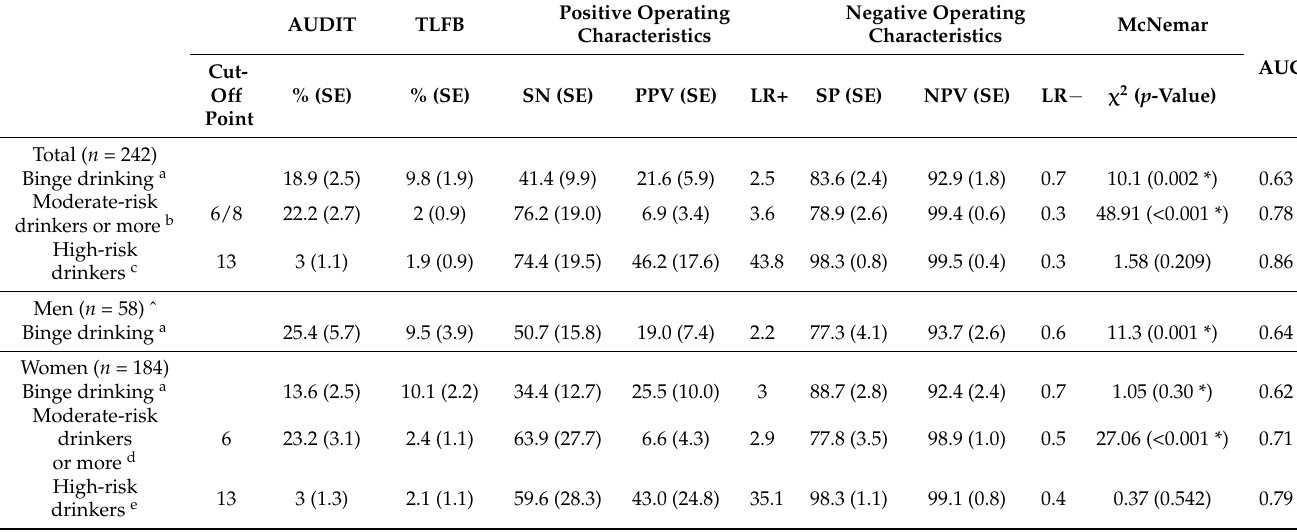
Table 4. Operating characteristics of AUDIT online questionnaire cut-off points for estimating reference standard (TLFB) prevalence of alcohol consumption in standard drink units (SDUs) per week by gender (weighted values).